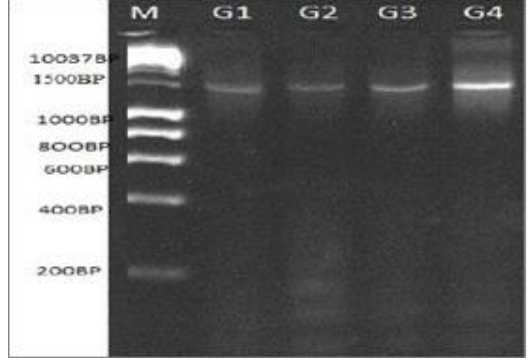
Figure 1 : Agarose gel electrophoresis showing positive amplification of 1,500 bp fragment of 16S rRNA gene of Klebsiella pneumoniae performed with strain-specific primer. Lane M: 200-1037 bp DNA ladder. Strain lane G1:1500bp from cattle while G2: AdM2 (1000-1700) isolated from cattle. G3 and G4 (Isolates from other sources: rain and well water respectively).